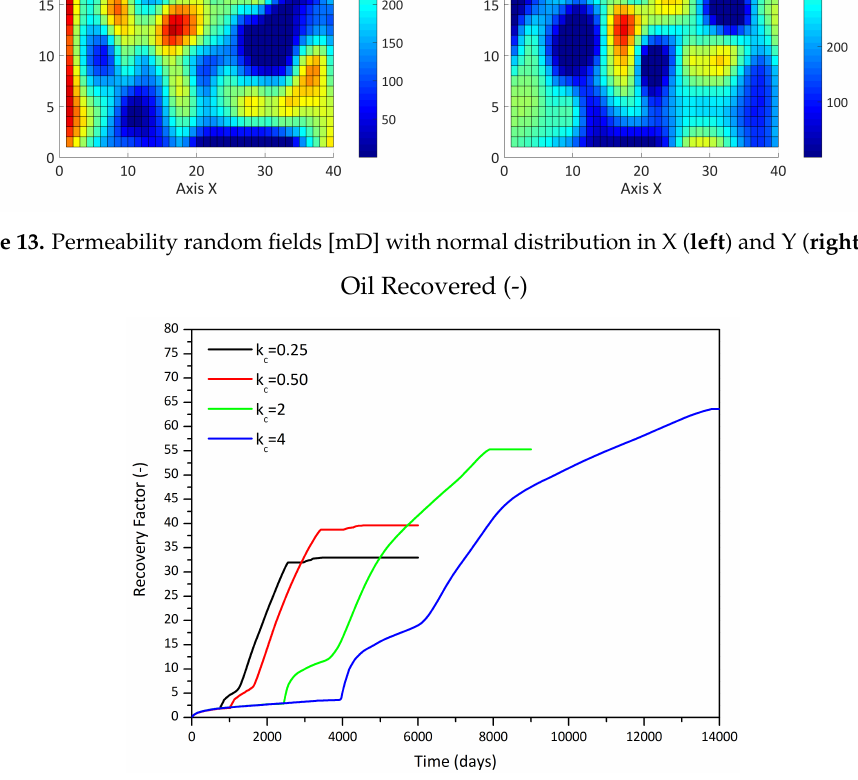
Figure 14. Oil recovered in a random permeability field as a function of